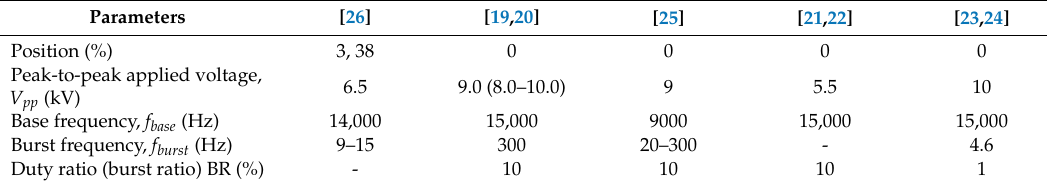
Table 2. Operational conditions of the DBD-PA-based flow control for